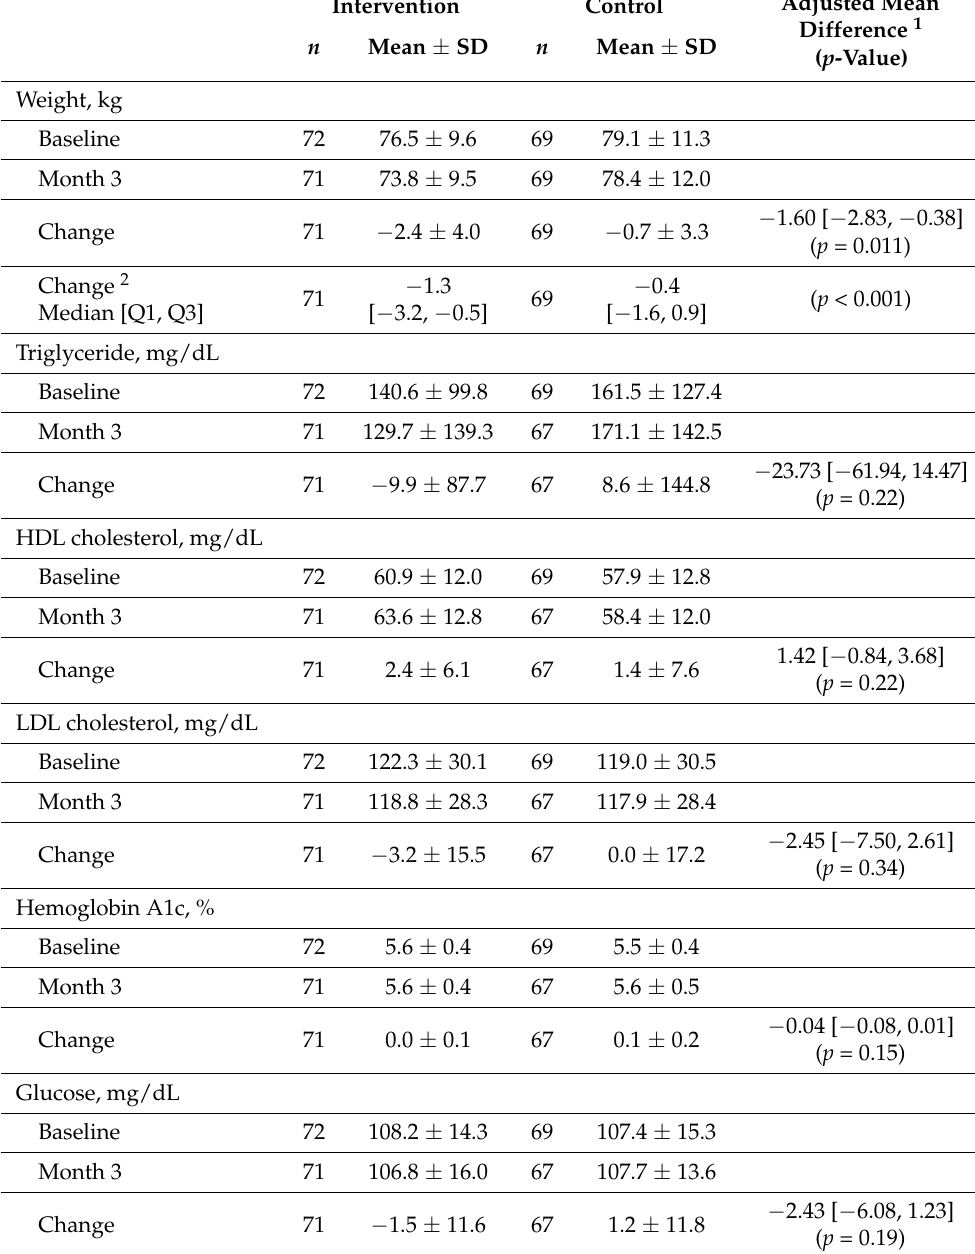
Table 2. Change in weight and blood biochemistry measures over 3